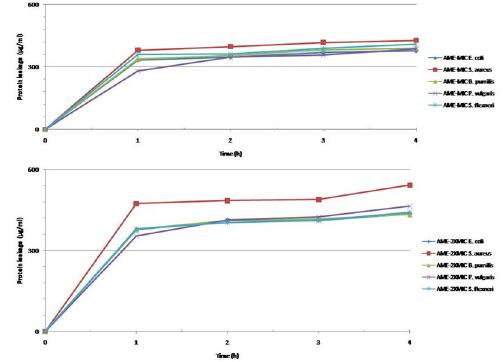
Fig. 11. Leakage of protein from different bacteria after treatment at their MIC and 2xMIC.